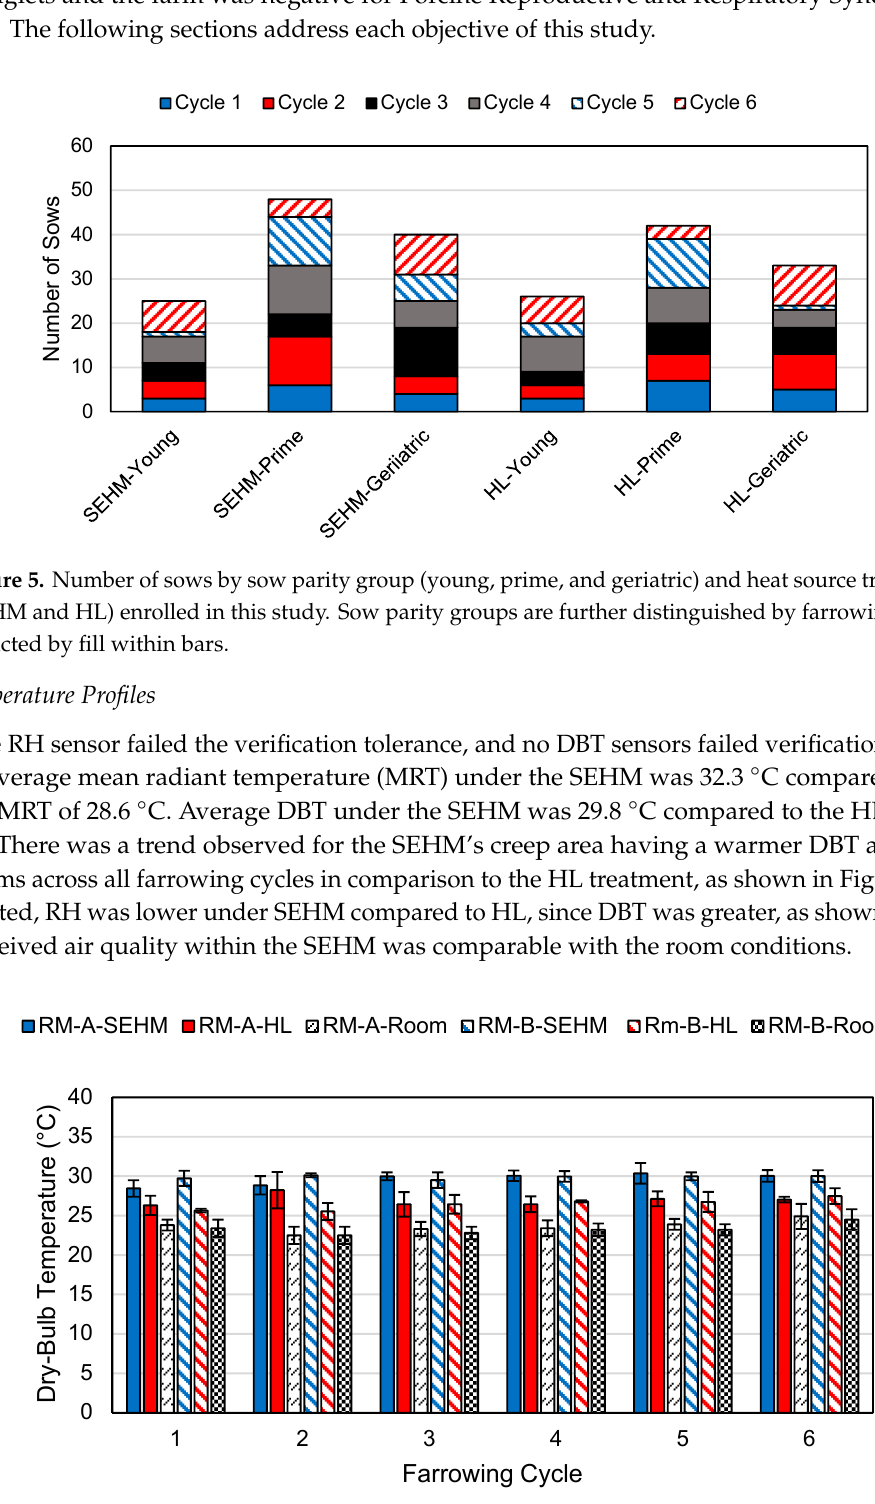
Figure 7. Mean radiant temperature of the creep area microclimate by heat source and farrowing cycle. Error bars represent one standard deviation of the mean.